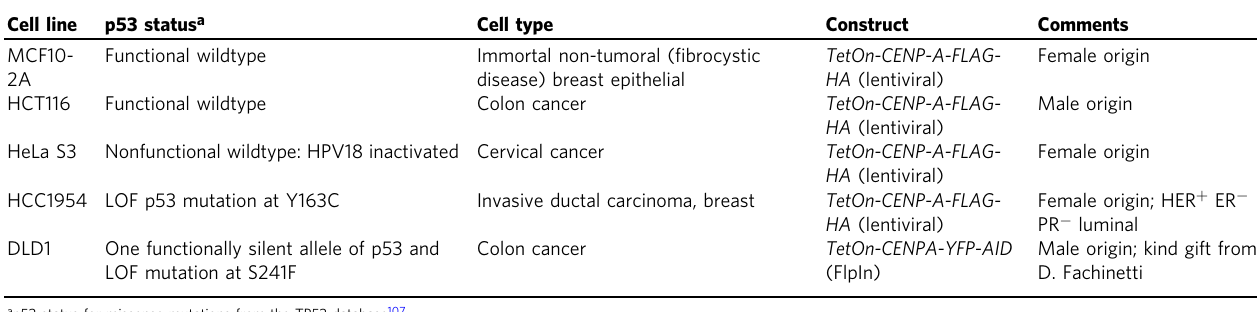
Table 1 Description of cell lines used and their p53